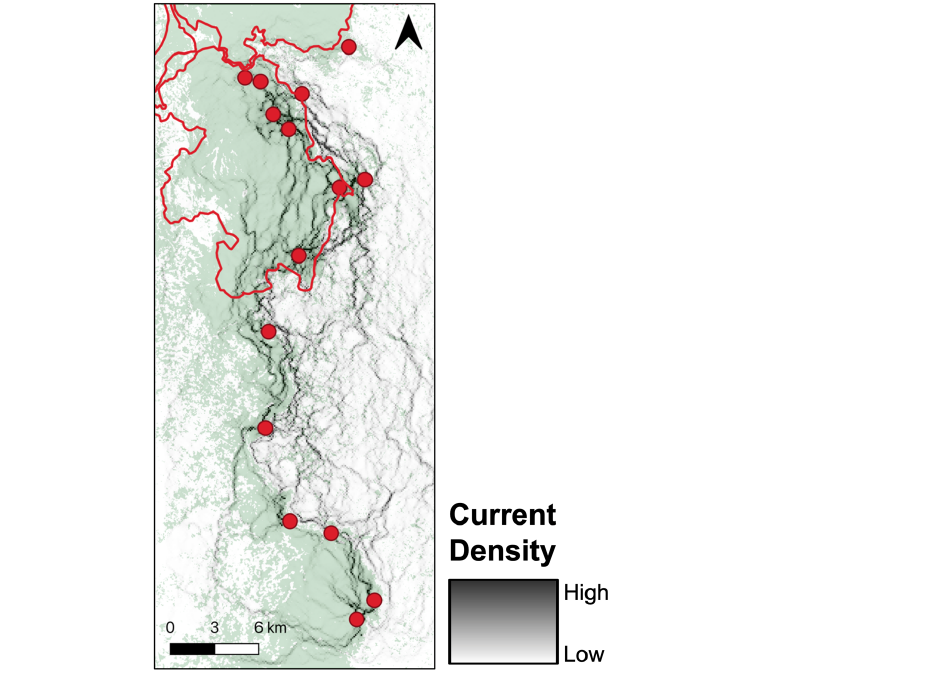
Figure 8. Cumulative resistance among individuals for optimized Terrain Ruggedness Index (TRI) created using Circuitscape v4.0.5 (https://circuitscape.org; accessed on 22 January 2019). Darker greys indicate areas of higher conductance (i.e., low resistance, high dispersal); lighter greys indicate areas of higher resistance (i.e., low conductance, low dispersal). Cumulative resistance is overlayed on 2016 forest cover and red circles represent the 15 sampling localities throughout the region.